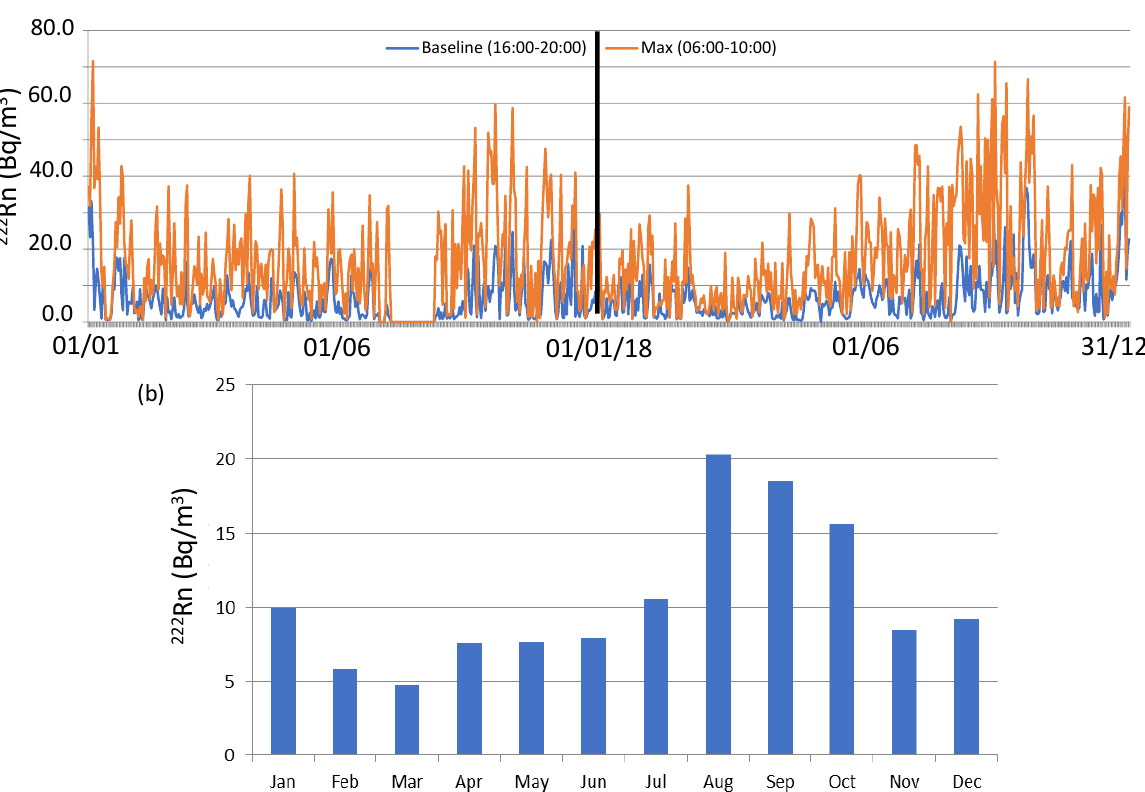
Figure 4. ( a ) Evolution of the 222 Rn baseline and maximum daily values at Bilbao, considering the average of the afternoon minimum (16:00 – 20:00 UTC) and morning maximum (06:00 – 10:00) measurements during the whole sampling period; ( b ) monthly difference between 222 Rn baseline and maximum daily values.